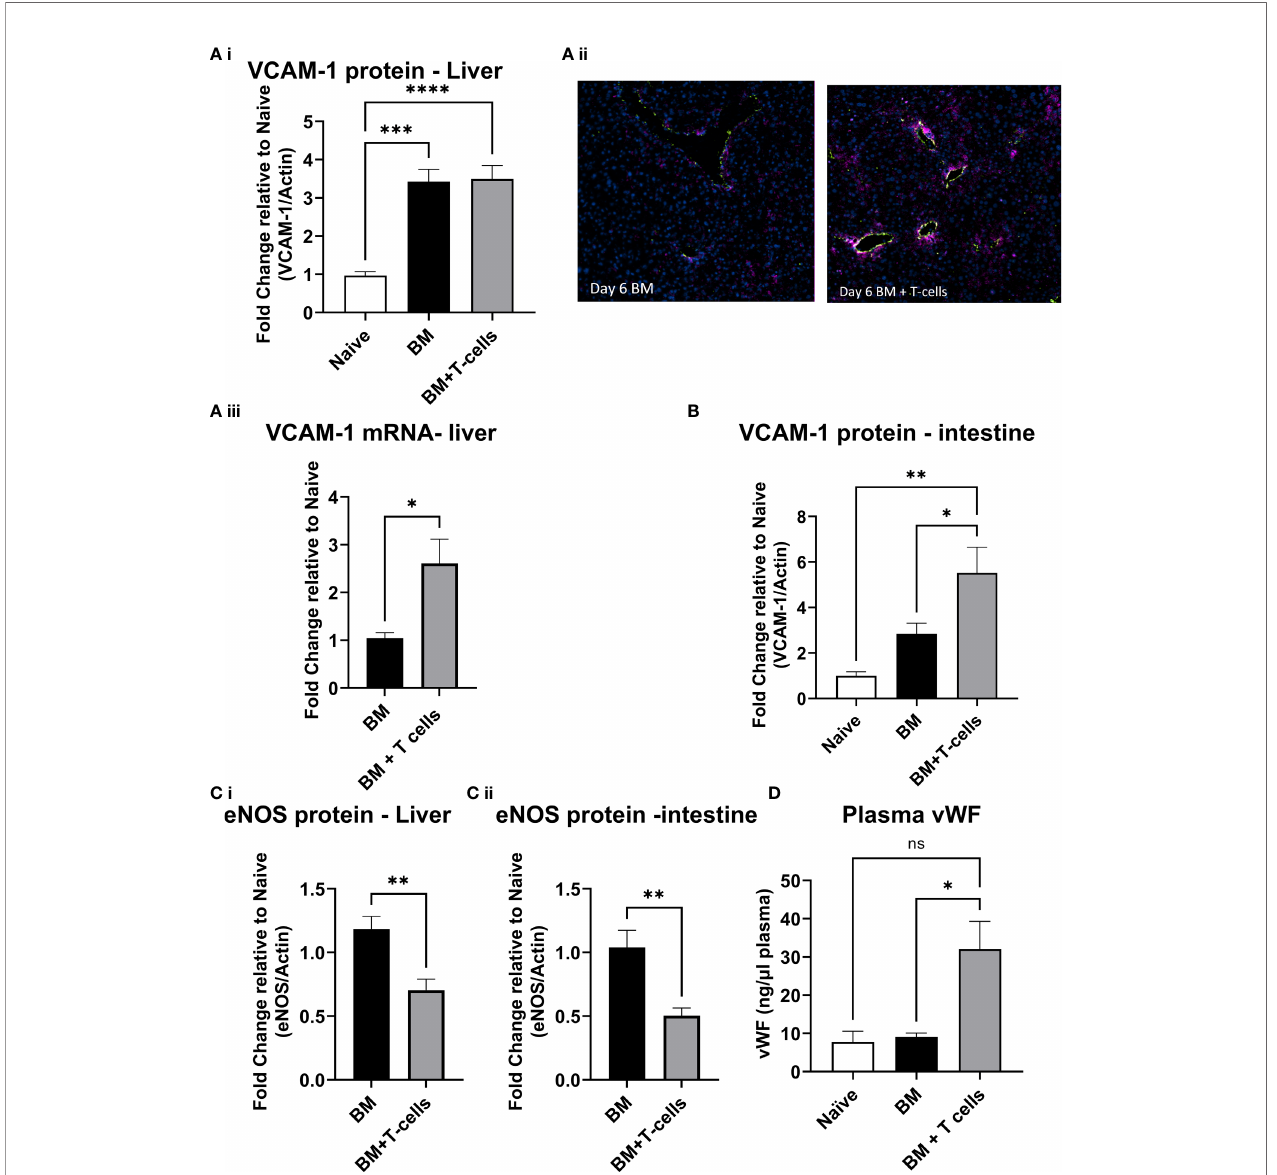
FIGURE 4 | Endothelial activation at day 6 post-GvHD- (A) (i) VCAM protein levels are increased in the liver at day 6 post BM and BM+T-cell transplant. ***p < 0.0001, n=7 naïve and n=13 BM and BM +T cells but (ii) endothelial VCAM-1 is increased selectively in the BM+T-cell transplant cohort (Immunostaining with anti- Von Willebrand Factor (green) to delineate the endothelium, anti-VCAM (purple) and DAPI to identify nuclei. Representative images of N=2 sections per mouse and n=3-4 mice per group. (iii) VCAM mRNA expression is higher in the BM+T cell cohort and (B) VCAM protein levels are signi fi cantly higher in the intestine of mice undergoing BM+T cells transplant. One Way ANOVA, with Sidak ’ s multiple comparison test. (C) Endothelial nitric oxide synthase (eNOS) is reduced in (i) liver and (ii) intestine con fi rming increased endothelial damage among mice transplanted with BM+T-cells. **p < 0.005; unpaired t test, n=6. (D) Plasma vWF is signi fi